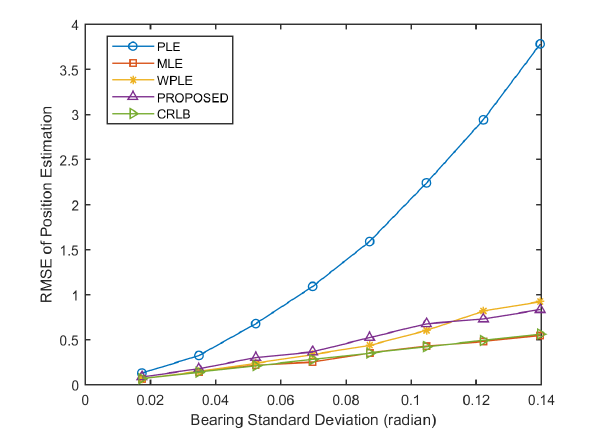
Figure 6. RMSE of position estimation versus bearing standard deviation.